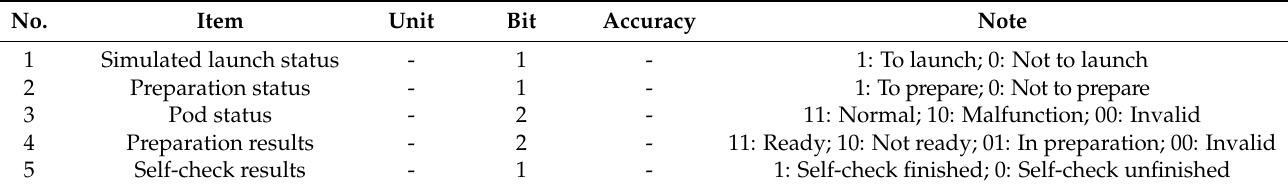
Table 6. Responses of the pod.